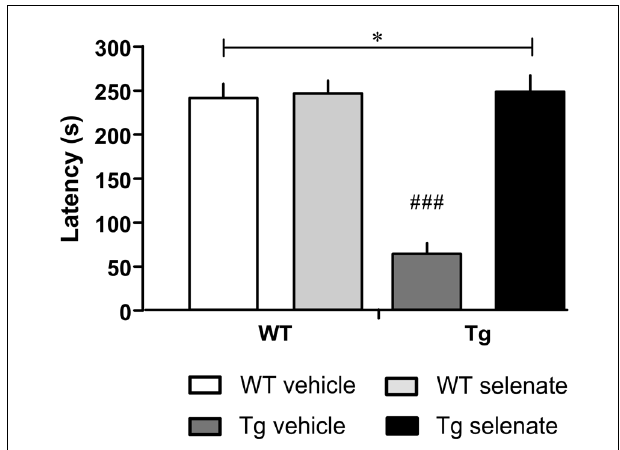
FIGURE 3 | Selenate restored impaired retention memory of Tg mice in the Passive Avoidance test. Mean ± SEM is given. Group sizes: Tg-veh n = 9, Tg-sel n = 10, WT-veh n = 8, WT-sel n = 10. A bar with a ∗ indicates p ≤ 0.01 in the Two-way ANOVA; ### represents p ≤ 0.0001 in the Dunnett post hoc